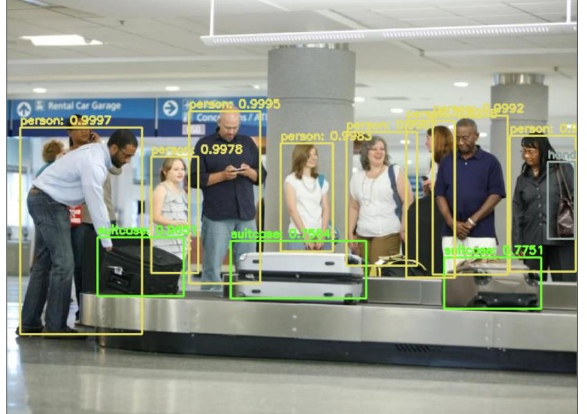
Figure 13. After detection.